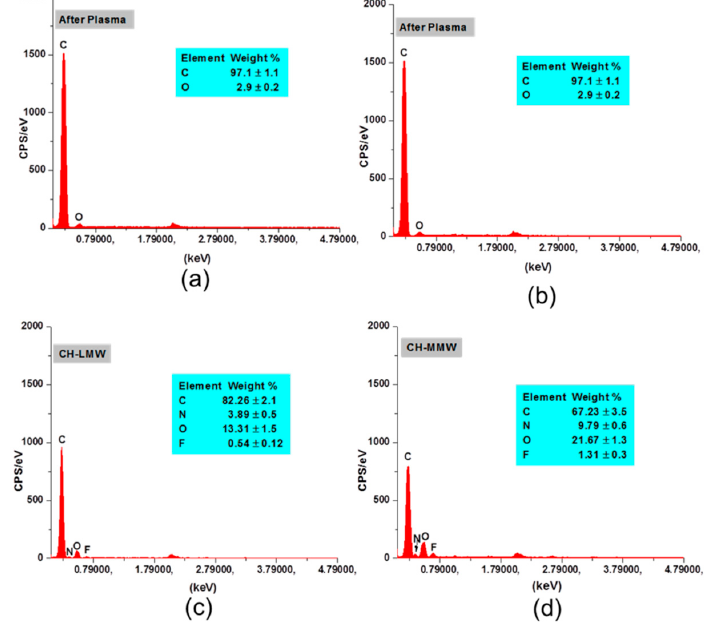
Figure 4. Energy dispersive X ‐ ray (EDX) spectra: ( a ) PP control, ( b ) oxygen plasma ‐ functionalized, ( c ) low molecular weight chitosan and levofloxacin, and ( d ) medium molecular weight chitosan and levofloxacin HCl ‐ coated PP meshes.